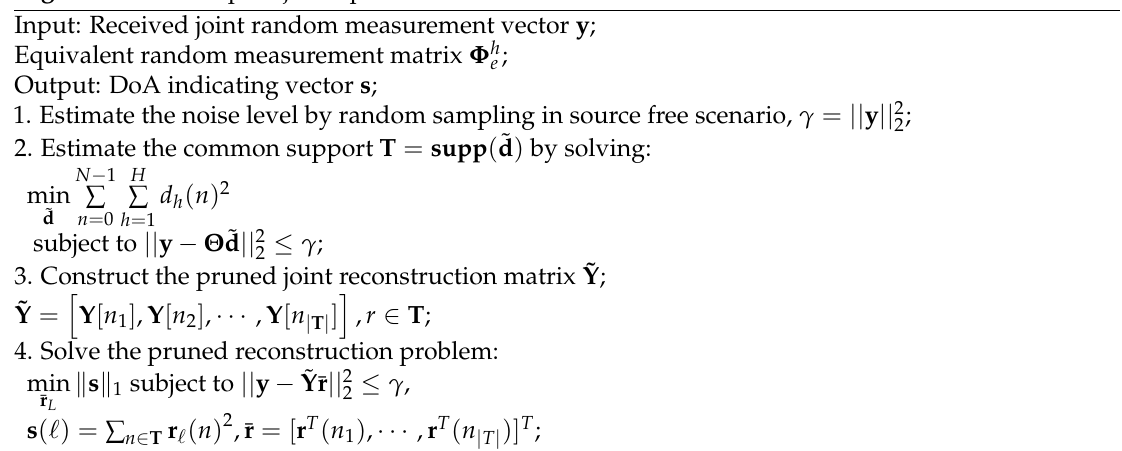
Algorithm 1 Decoupled joint sparse